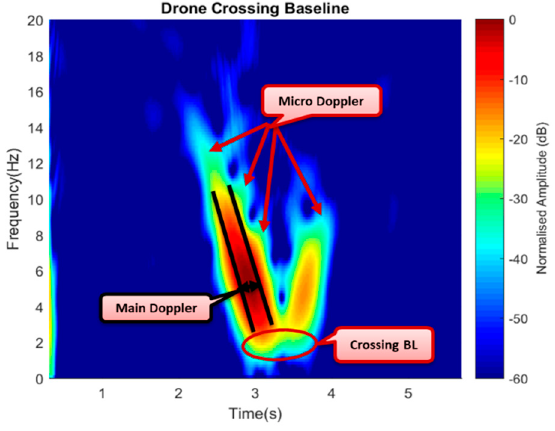
Figure 19. Extracted micro-Doppler from the blade and main Doppler from the body.